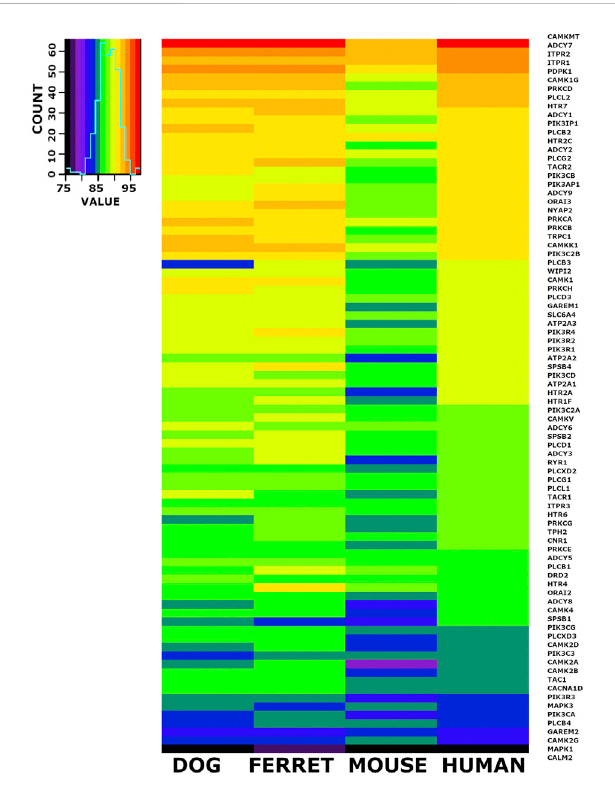
FIGURE 5 Heat Map Illustrating Identity Between Shrew cDNA and Orthologs of Emesis Candidate Genes. A set of 84 cDNAs from the emesis candidategenesetwascomparedatthenucleotidelevelbetweenshrew and dog, ferret, mouse, and human.Resultsare represented inheat map format. The color key and histogram in the upper left corner providesamappingbetweenheatmapcolorsandthecountofcDNAsin each color category. The data is ordered by the nucleotide identity relationship between shrew cDNAs and corresponding orthologous human cDNAs in the last